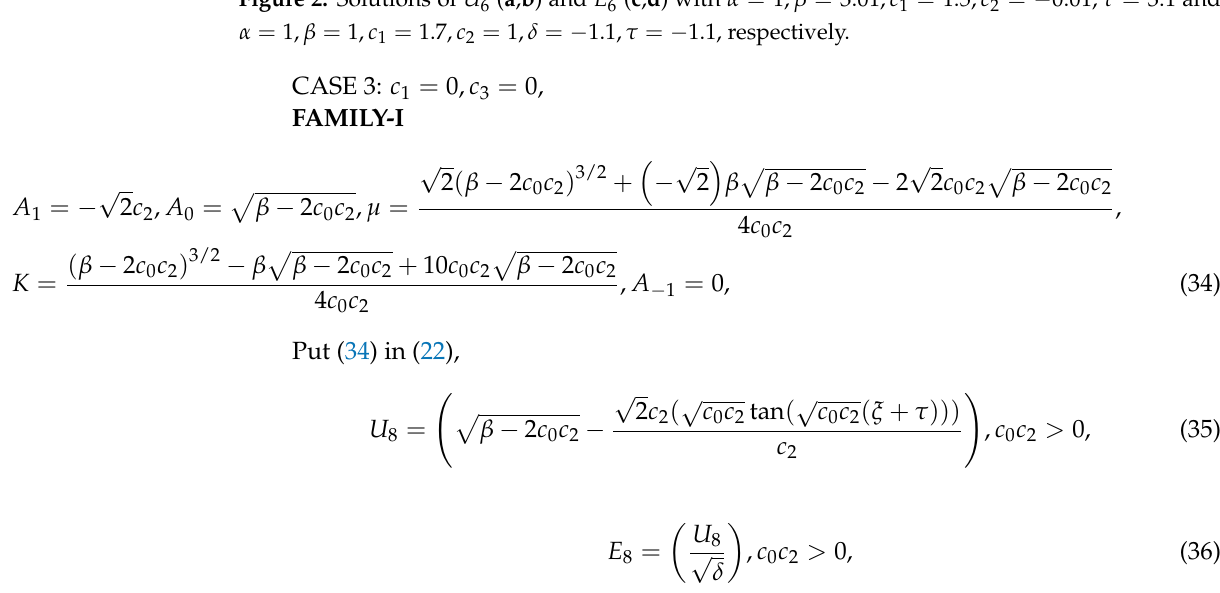
Figure 2. Solutions of U 6 ( a , b ) and E 6 ( c , d ) with α = 1, β = 3.01, c 1 = 1.5, c 2 = − 0.01, τ = 3.1